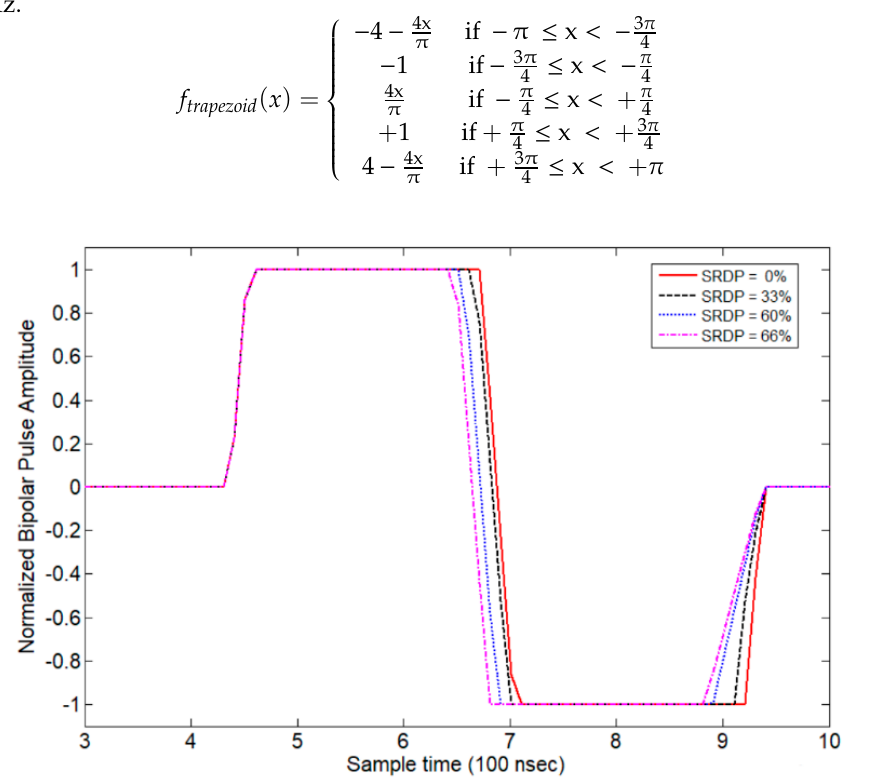
Figure 2. Simulated bipolar pulse waveforms with different SRDP between 0% to 66%.